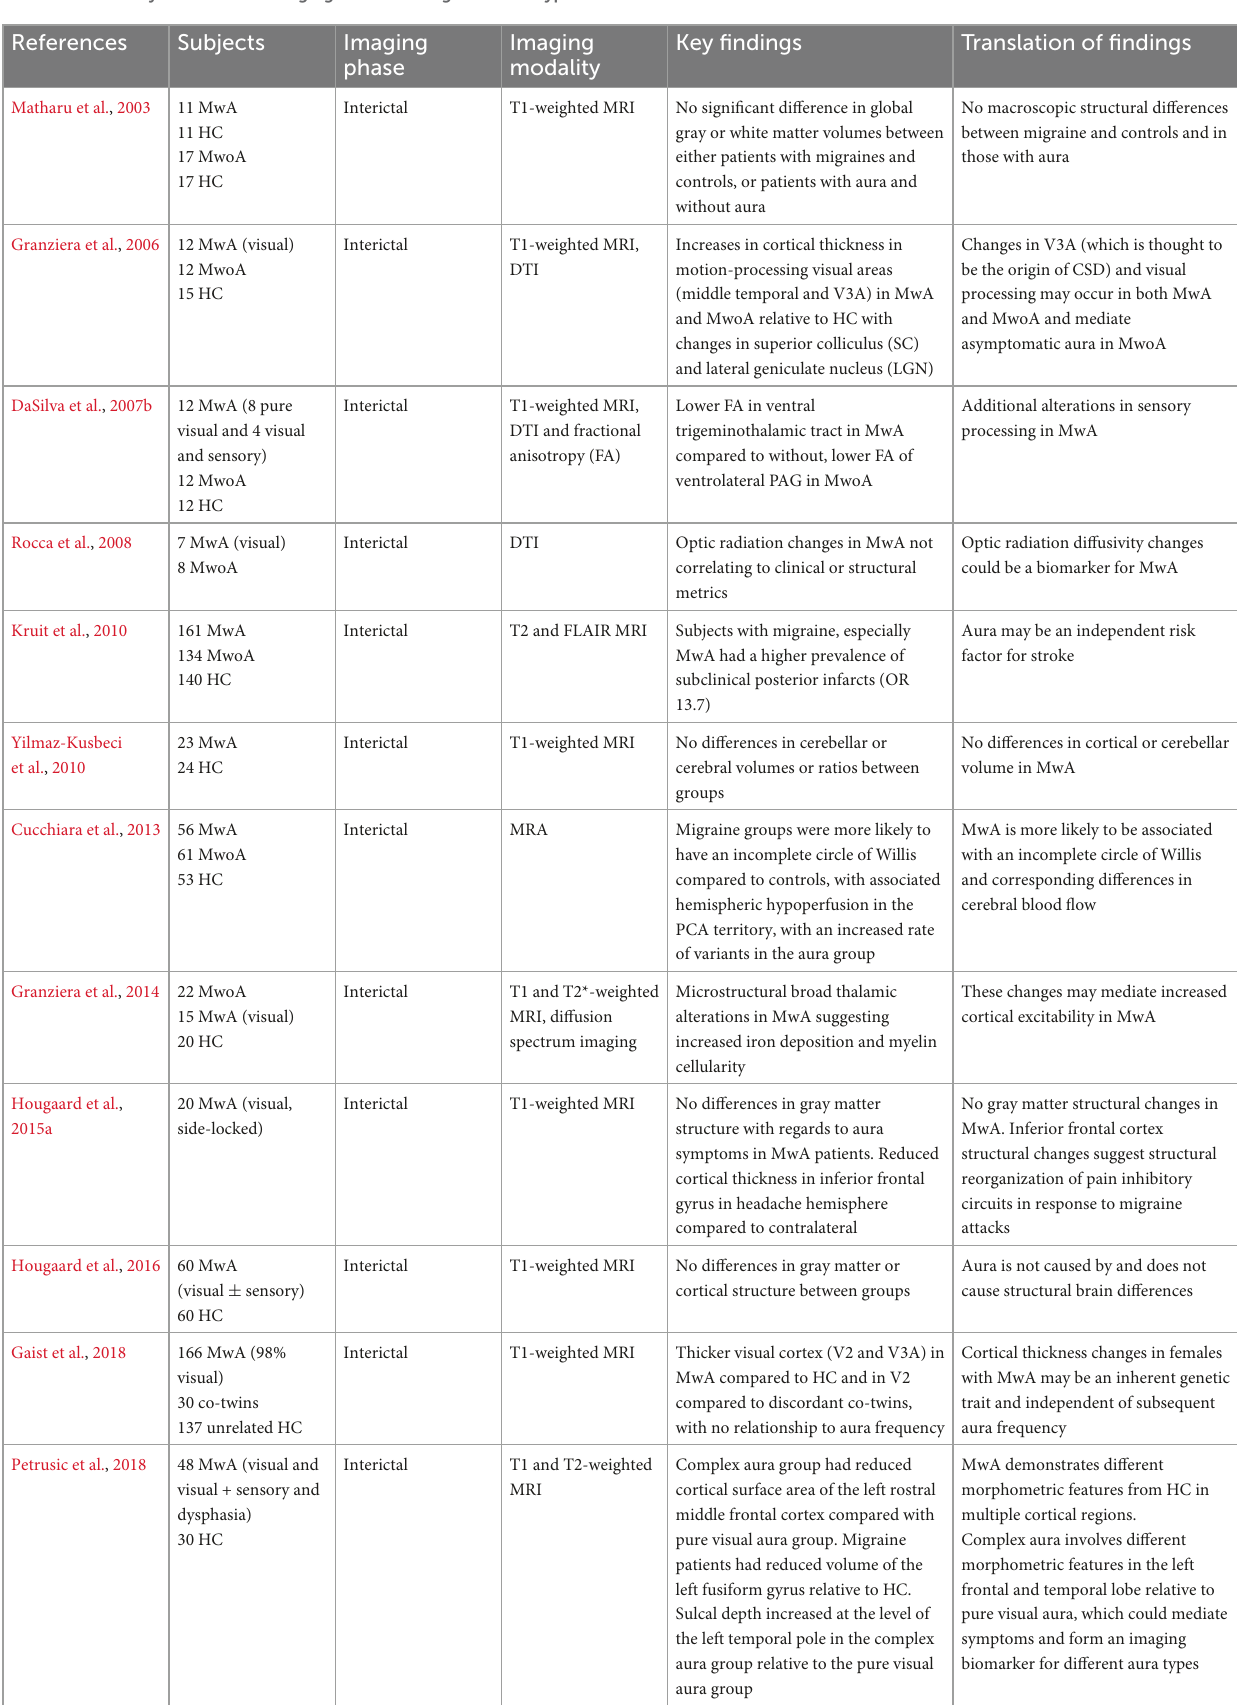
TABLE 1 Summary of structural imaging studies in migraine with typical